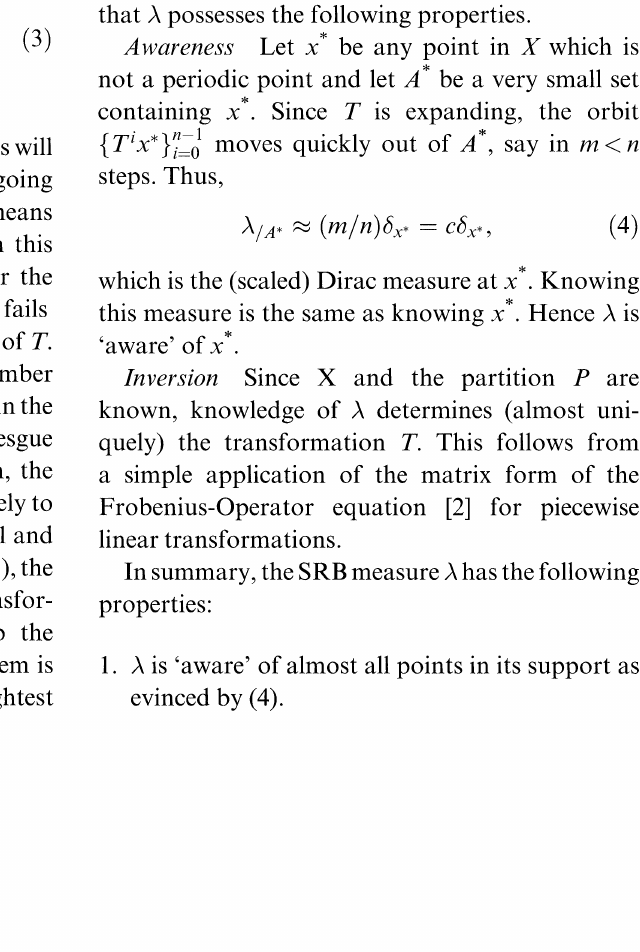
FIGURE 2 One dimensional triangle transformation